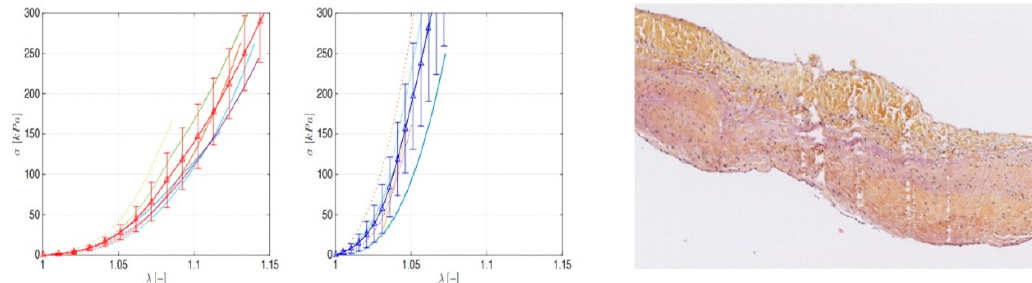
Figure 6. Left panel: Stress–stretch curves for pulmonary (left) and aorta (right) leaflet. Right panel: Human pulmonary valve explanted 22 years after Ross operation shows a small sector of fibrous densification.